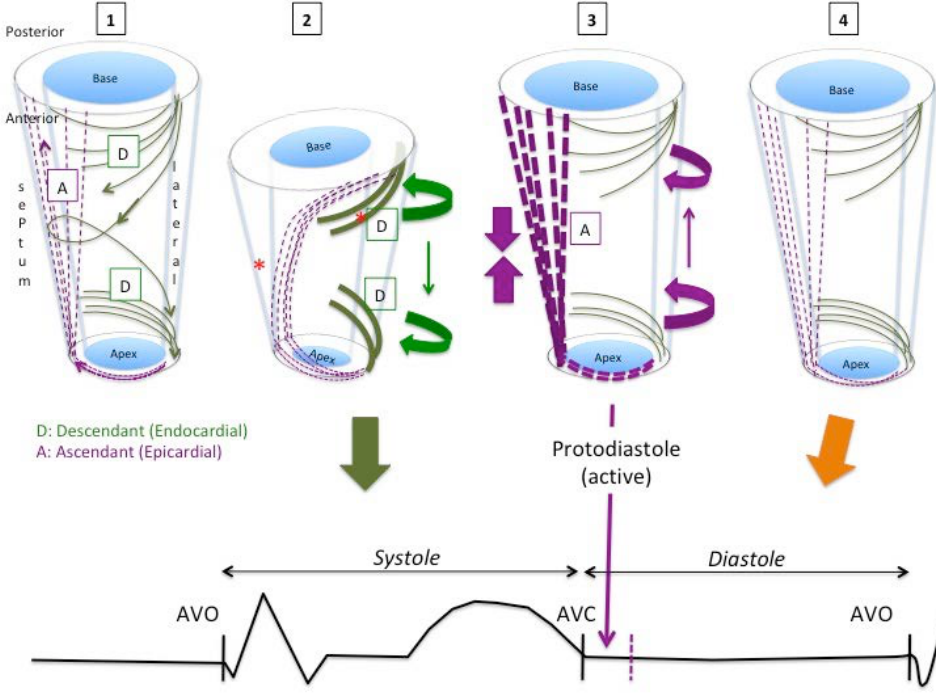
Figure 5. Frontal view. Diagram showing the behavior of the descending (green) and ascending (discontinuous purple) components of the apical loop. ( 1 ): In a telediastole, with the myocardium inactivated. ( 2 ): In a systole, electromechanical activation begins at the mid-septum and basal-lateral (asterisk), and spreads towards the apex and base, and from the endocardium to the epicardium. Contraction of the descending fibers (thick green) causes basal and apical rotation in opposite directions (twist) and longitudinal shortening of the ventricles by displacement of the base towards the apex, which results in stretching of the more epicardial ascending fibers (discontinuous purple). ( 3 ): The subsequent contraction of the ascending fibers (heavy discontinuous purple) causes longitudinal straightening and untwisting of the ventricle, coinciding with the period of isovolumetric filling. ( 4 ): Myocardial relaxation concludes during the diastole. NOTE: The basal loop, which wraps up and is stimulated simultaneously by the descending portion of the apical loop, is not represented in the graph.